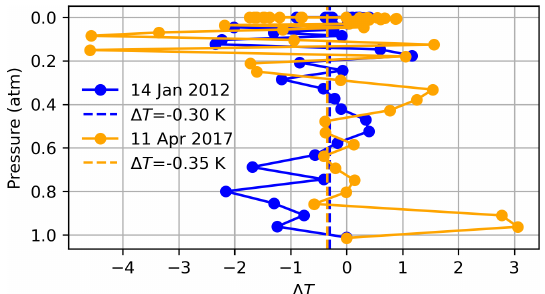
Figure 11. Temperature profile difference for the GGG2020 a priori minus radiosonde on 14 January 2012 and 11 April 2017. The ra- diosonde profile is included in the a priori profiles used in panel (a) of Figs. 9 and 10, and the GGG2020 a priori profiles are used in panel (b) of Figs. 9 and 10. In situ temperature measurements are used for both cases at the surface. The dashed line marks the average difference, with the value indicated in the legend.